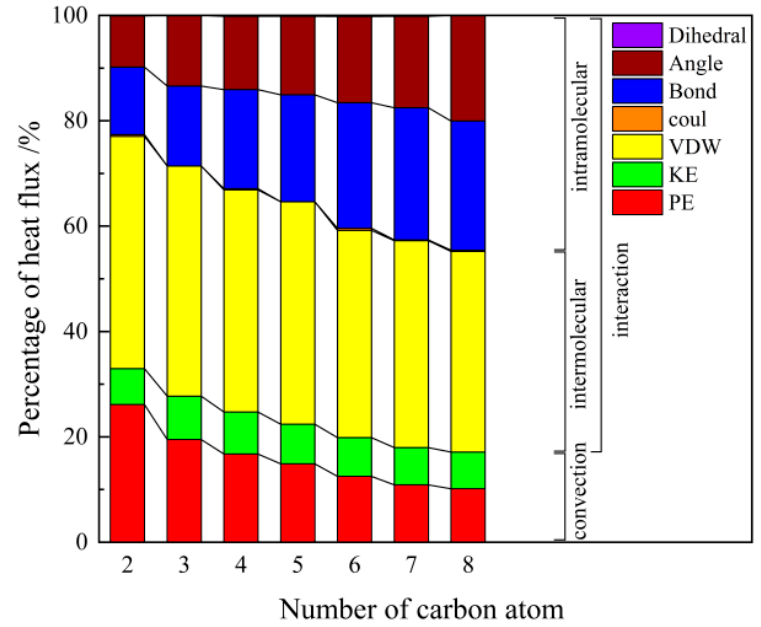
Figure 7. Contribution of energy transfer in each part to the total heat flux for seven species of alcohols at 323.15 K.